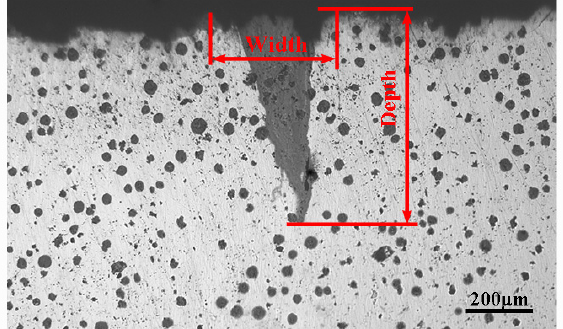
Figure 3. Crack of unrepaired thermal fatigue sample.